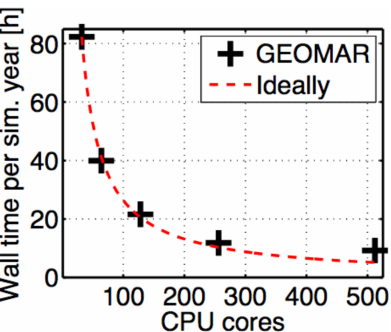
Figure 29. Computational performance as a function of CPU cores put to work simultaneously. On 500 Intel Xeon CPU E5-2670 cores, it takes 10h to simulate 1 year.